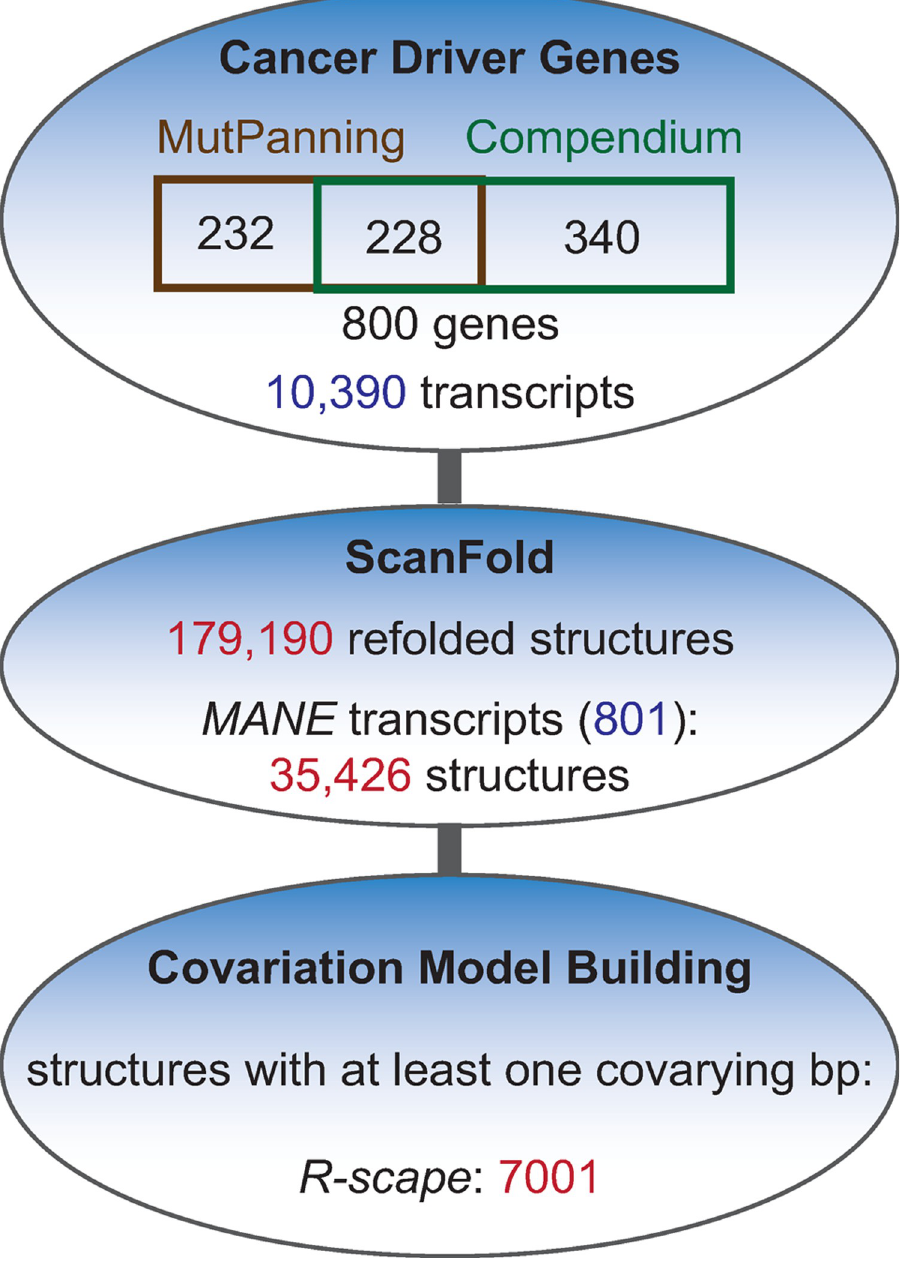
Fig 1. Flow diagram for study outline. Top oval shows the numbers of cancer driver genes and transcripts included in this study, as well as their sources–either from Mutpanning [3] or the Integrative OncoGenomics Compendium of drivers [4]. The gene symbols surrounding the flow diagram include all 800 genes in this study. The second oval shows the number of structures that were extracted from all the transcripts as well as from the matched annotation for NCBI and Ensembl (MANE) transcripts chosen for further analysis. The number of MANE structures exhibiting at least one covarying base pair (bp) after covariation analysis using structure-informed R-scape [12, 13] are shown in the bottom